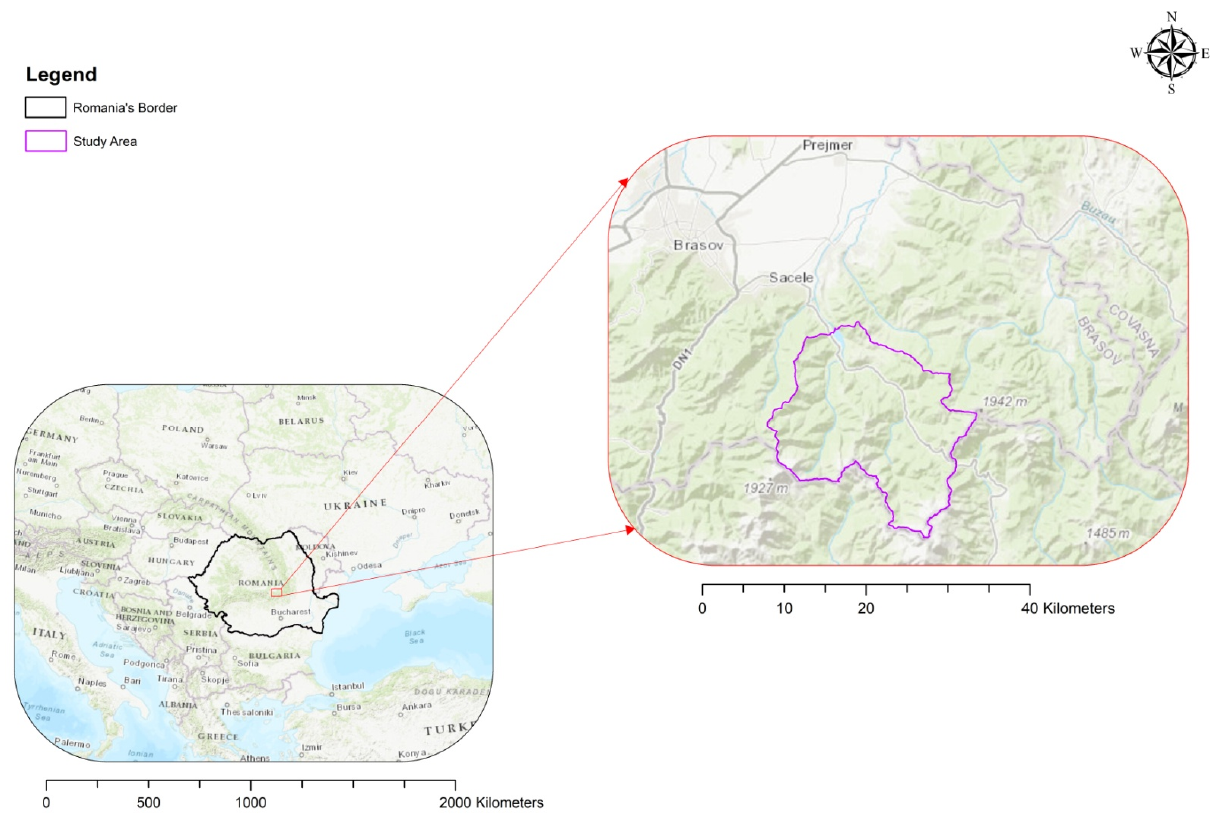
Figure 1. Study area location.